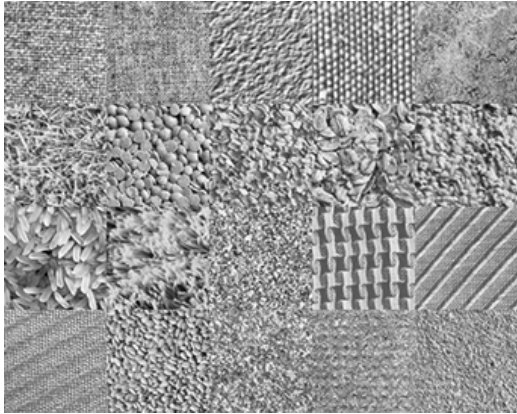
Figure 3. Samples of the 20 categories randomly selected from the Kylberg database.